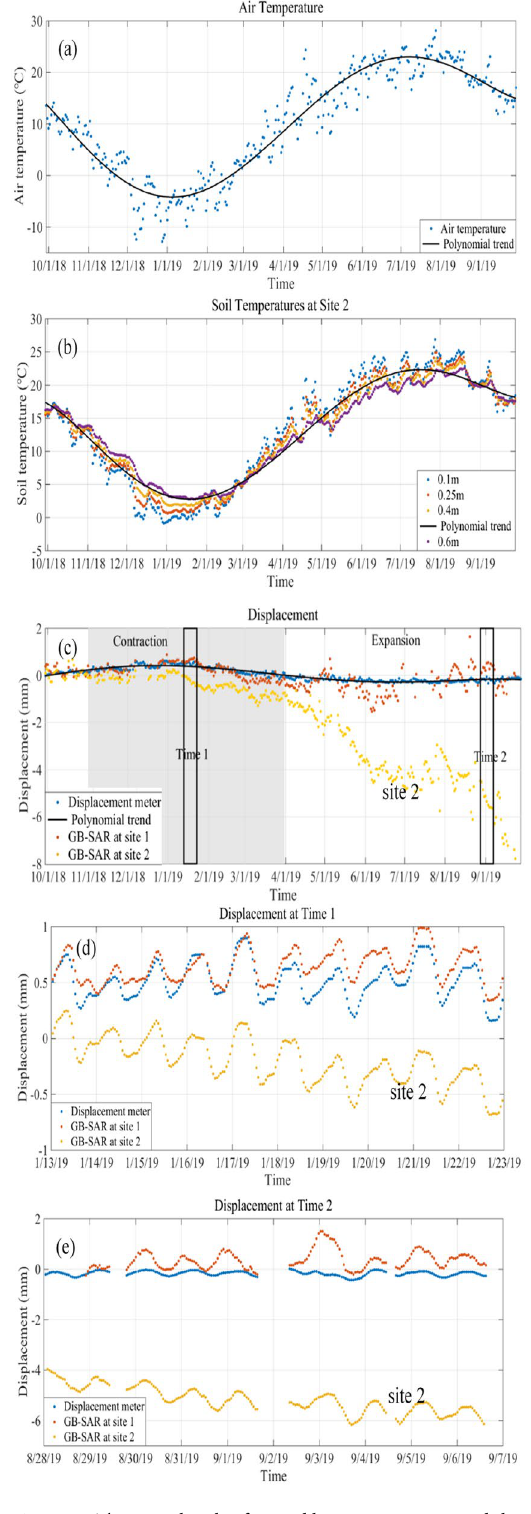
Figure 6. The annual cycle of air and loess temperature, and slope expansion/contraction between 30 September 2018 and 1 October 2019. ( a ) Daily average air temperatures (dots) and their polynomial trend (black line). ( b ) Daily average soil temperatures (dots) at site 2 and their polynomial trend (black line) at four depths. ( c ) Daily deformation measured at sites 1 and 2 with GB-SAR sensor and the displacement meter (black line is the polynomial trend for the displacement meter). ( d ) and ( e ) Deformation measured by the displacement meter and GB-SAR sensor between the 13 and 23 January 2019 and between August 28 and 17 September 2019. Negative and positive displacement values indicate movement towards and away from the GB-SAR sensor. Observations suggest a close correlation between air temperature and slope expansion/contraction at the annual